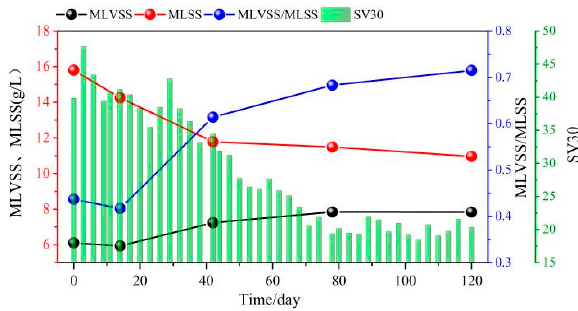
Figure 5. Sludge microbial content and sedimentation performance.